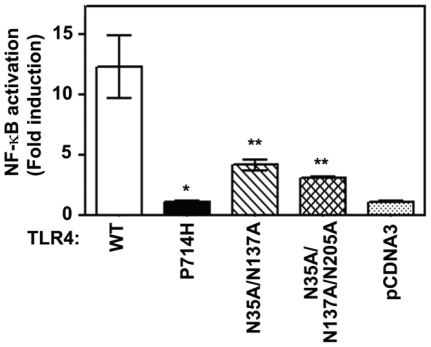
Effect of P714H, N35A/N173A, and N35A/N173A/N205A mutations on the ability of TLR4 to mediate LPS-induced activation.HEK293T cells were co-transfected with expression vectors encoding wild type TLR4 (WT) or P714H, N35A/N173A, and N35A/N173A/N205A mutants along with pEFBOS-MD2, pCDNA3-CD14, pELAM-luc, and pTK-Renilla-luc. Transfected cells were stimulated with LPS for 6 h, and firefly vs. renilla luciferase activities were measured in cell lysates. Data were processed using Student t-test. *p<0.005; **p<0.05 (vs. WT).